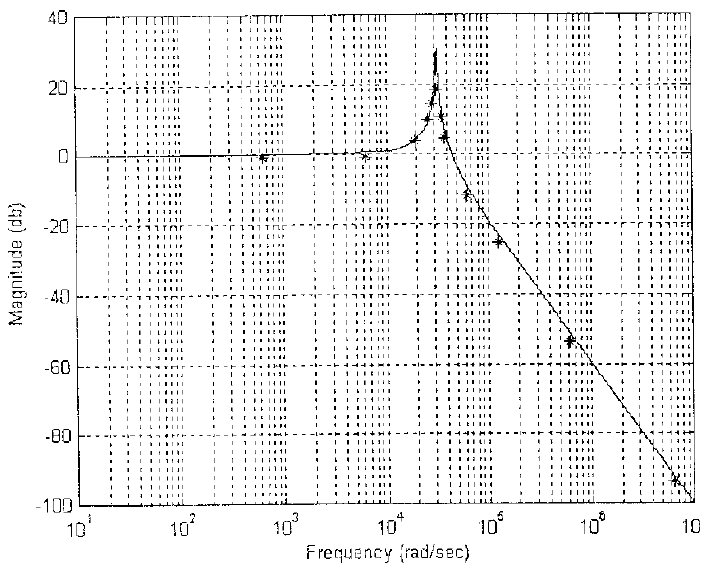
FIGURE 2 Calculated (____) and simulated (**) characteristics of the current-mode LPF obtained from I out 3 with V in 1 ¼ V in 2 ¼ I in 2 ¼ 0.